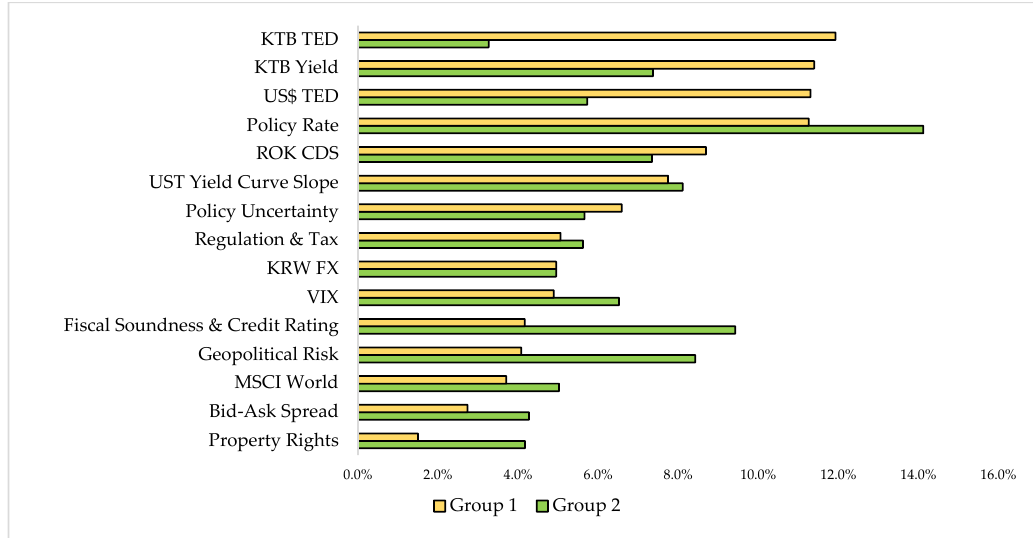
Figure 12. Global weights between group 1 and group 2.